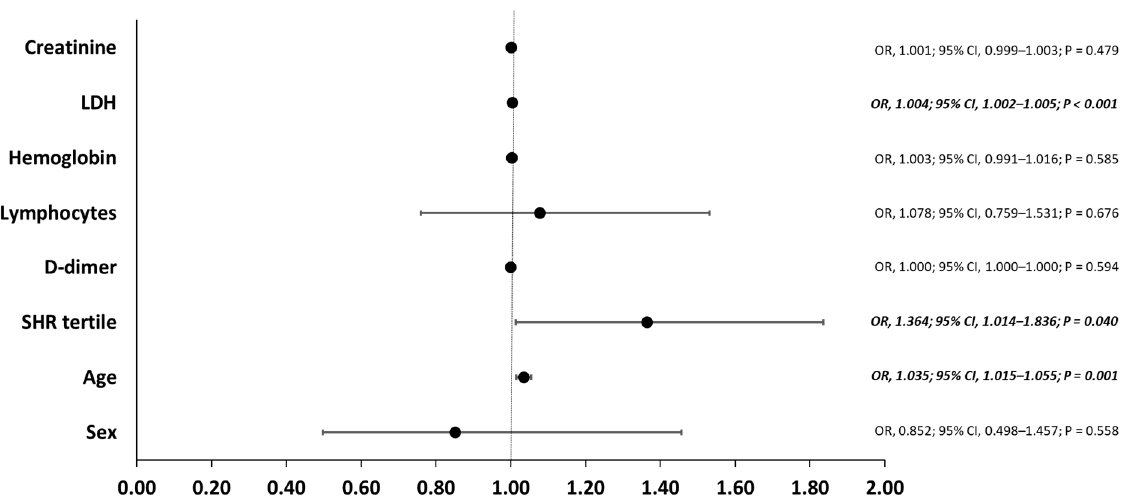
Figure 2. Risk factors for the primary outcome. For each variable, the black dot represent the odds ratio, and the horizontal line represent the 95% confidence interval. Abbreviations: CI, confidence interval; LDH, lactate dehydrogenase; OR, odds ratio; SHR, stress hyperglycemia ratio.